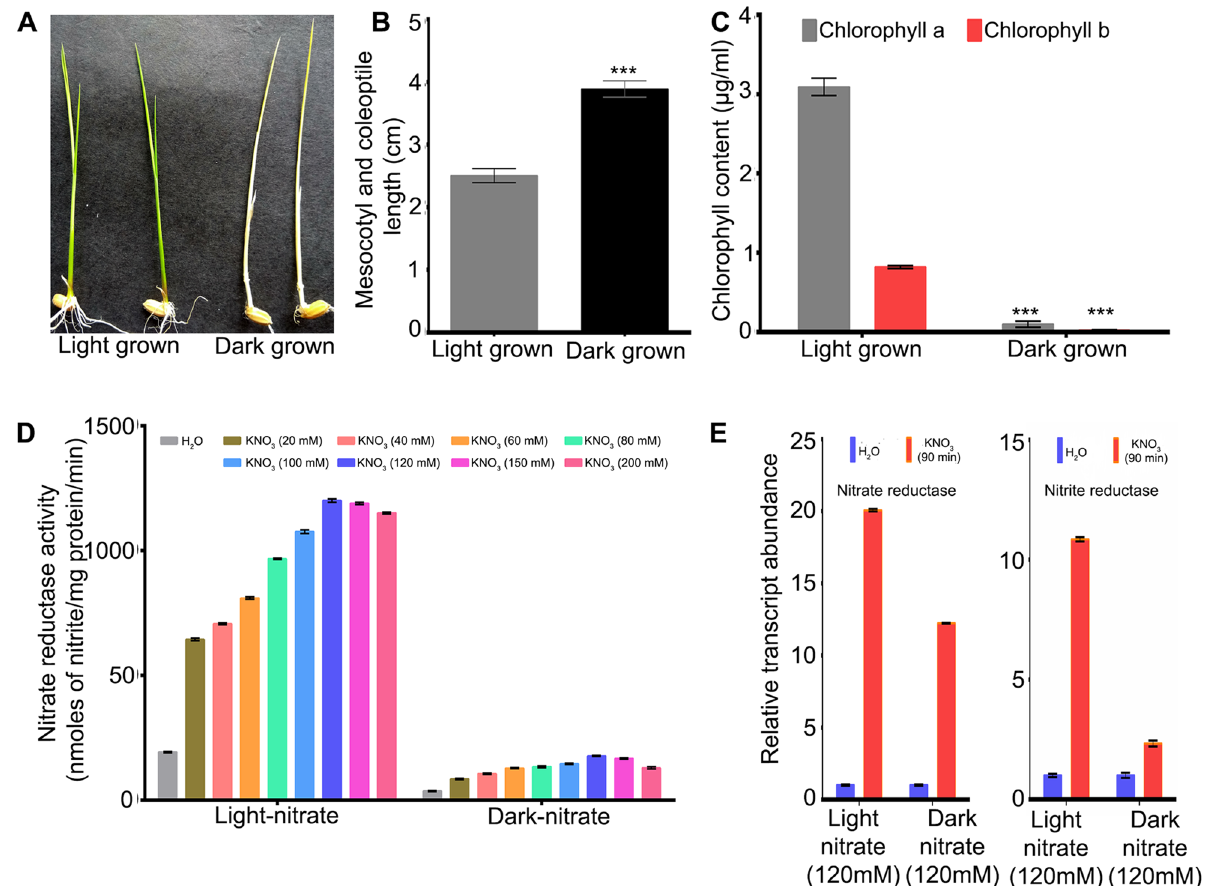
Figure 1. Phenotypic, physiological and molecular analyses of nitrate responses in 10 days old light-grown and etiolated seedlings in rice. ( A ) Representative image of light-grown and etiolated seedlings. ( B ) Mesocotyl and coleoptile length of light-grown and etiolated seedlings and data represent the average of 16 seedlings. ( C ) Leaf chlorophyll content. The data represents the means ± SD of three independent biological replicates. ( D ) Effect of nitrate doses on nitrate reductase activity in the leaves of light-grown and etiolated seedlings. ( E ) Relative expression level of nitrate reductase and nitrite reductase genes in the leaves of light-grown and